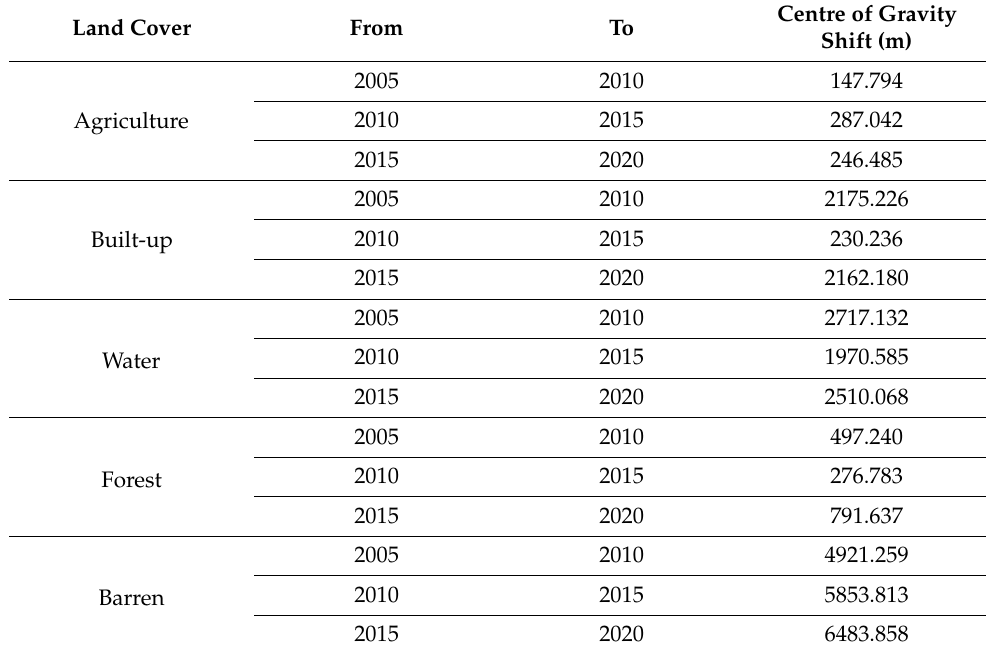
Table 5. Centre of gravity shift in meters for Rupandehi District, Nepal. Land Cover From To